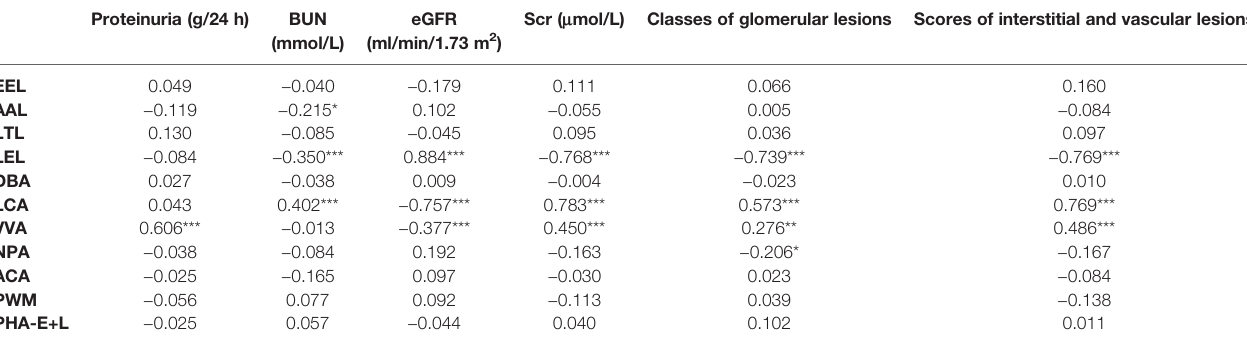
TABLE 1 | Pearson ’ s correlation of expression levels of glycopatterns in the saliva and clinical and pathological indicators related to the severity of diabetic nephropathy. Proteinuria (g/24